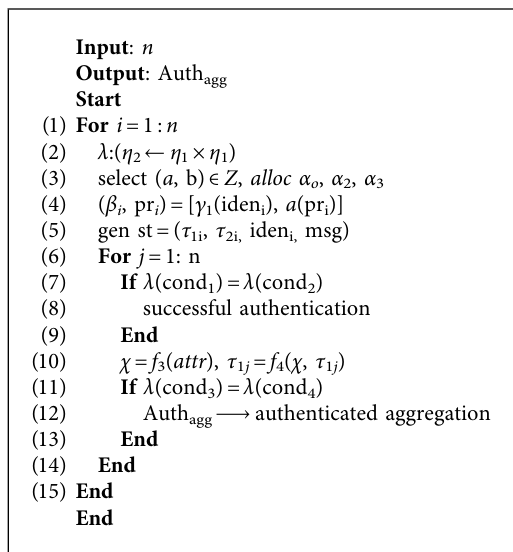
algorithm’s third process is embedding a validation